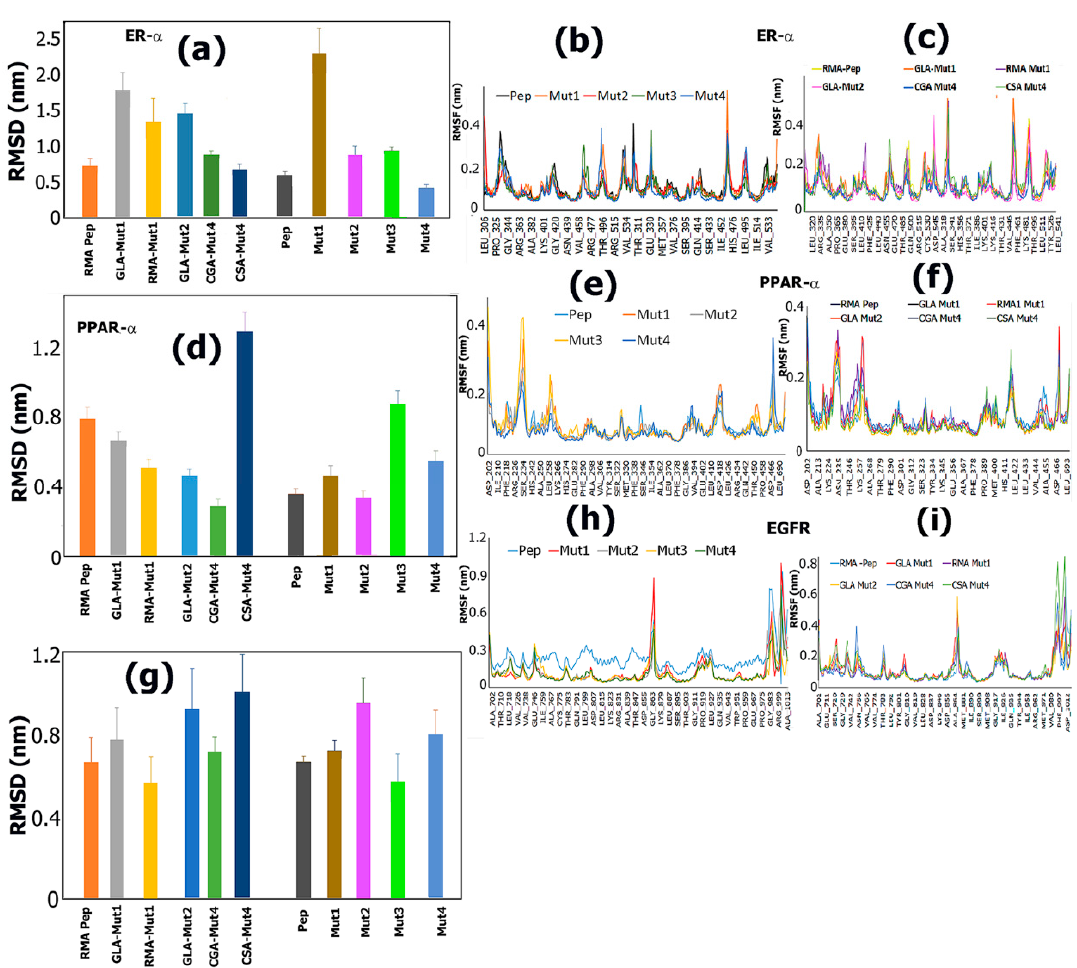
Figure 8. Comparison of RMSDs (72 ns–100 ns). ( a ) ER α ; ( d ) PPAR α ; ( g ) EGFR. RMSFs for the entire 100 ns runs are shown for each of the receptors with ( b ) and ( c ) corresponding to ER α ; ( e , f ) corresponding to PPAR α ; ( h , i ) corresponding to EGFR.